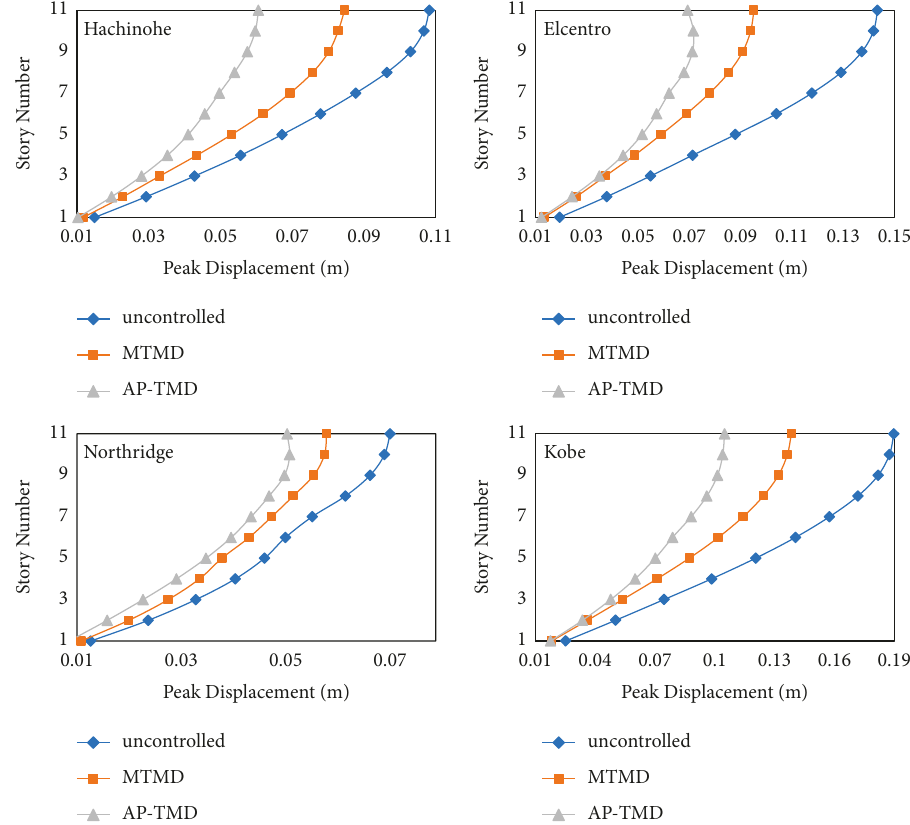
Figure 8: Maximum displacement of structural floors with MTMD and AP-TMD